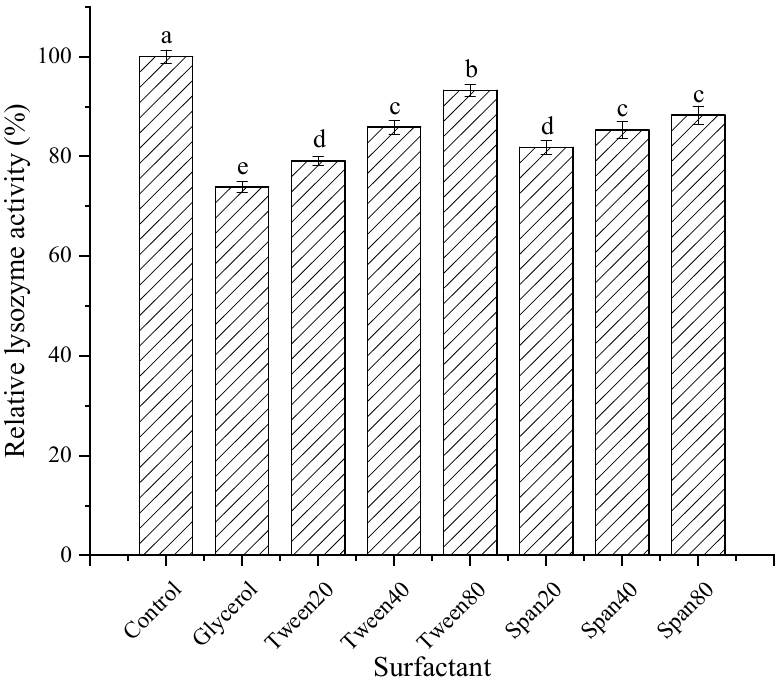
Figure 12. Effect of surfactants on activity of lysozyme from SDEW.